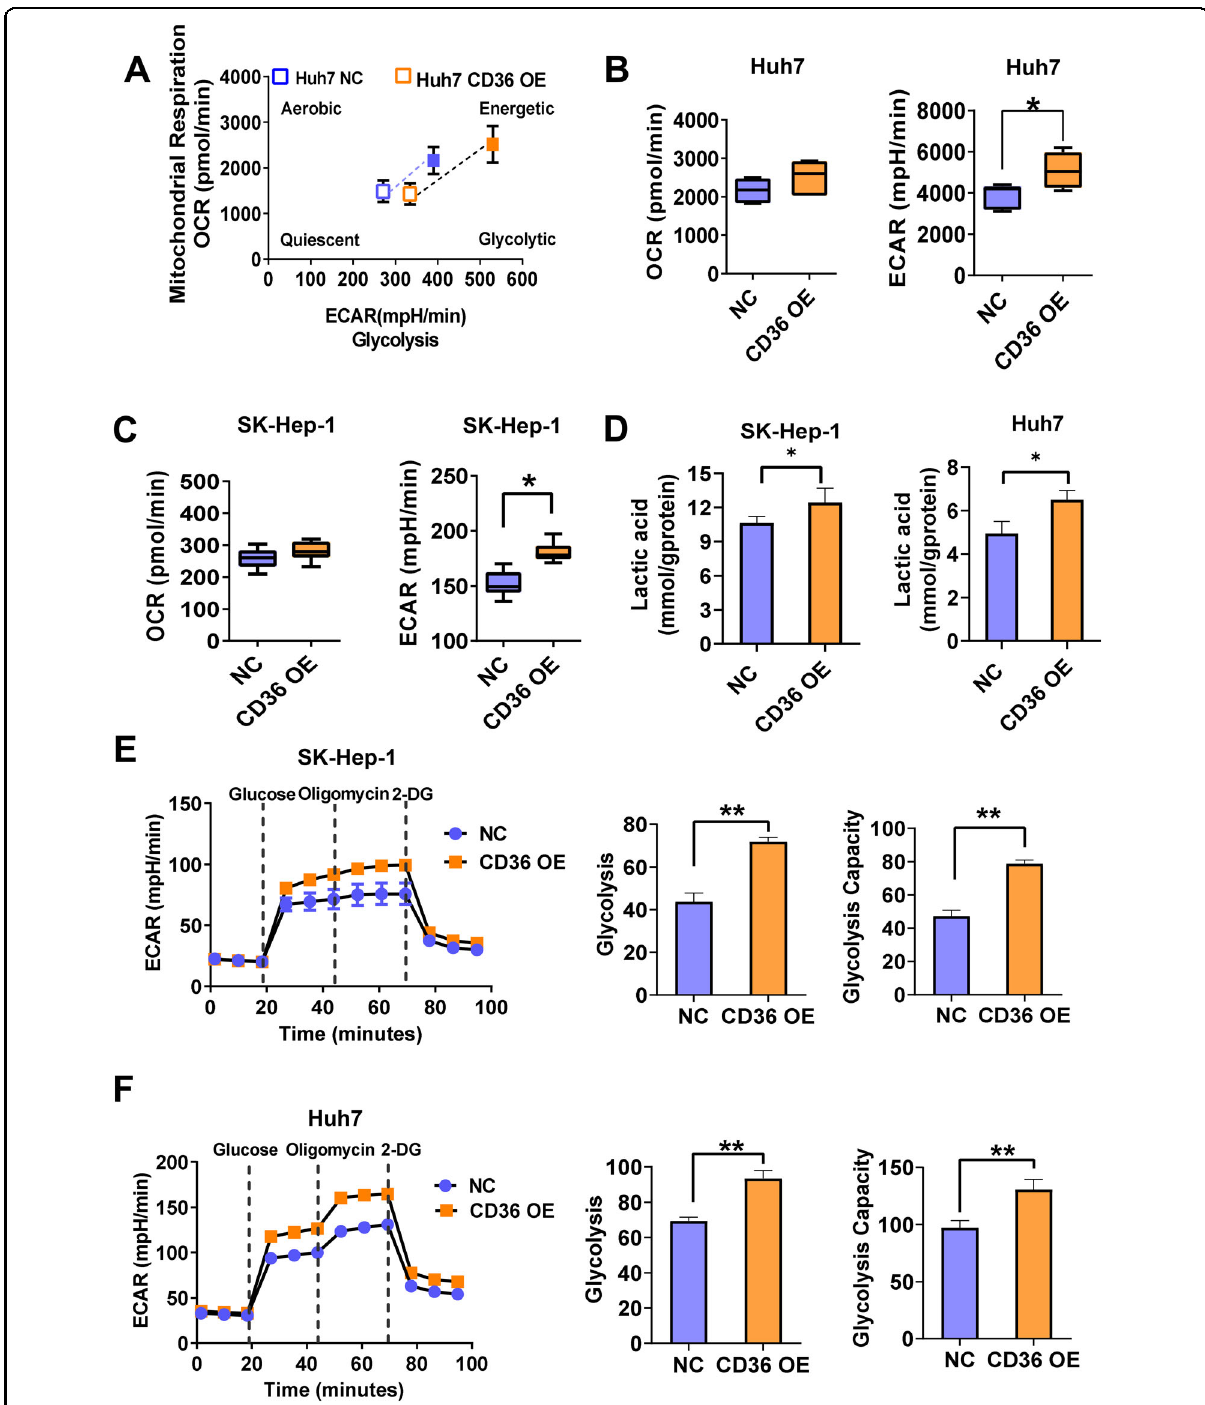
Fig. 5 CD36 promotes glycolysis in HCC cells. The energy metabolism phenotype and glycolytic capacity of CD36 OE or control cells were measured by the Seahorse XFe 24 Analyzer. A Energy metabolism phenotype of CD36 OE or control Huh7 cells. B , C The stressed OCR and ECAR of Huh7 and SK-Hep-1 cells ( n = 3). D The lactic acid production of SK-Hep-1 and Huh7 cells ( n = 6). E , F Glycolytic capacity of Huh7 and SK-Hep-1 cells was measured by glycolytic stress test ( n = 3), the key parameters of glycolytic fl ux including glycolysis and glycolytic capacity were shown on the right. All data are presented as mean ± SD. * P < 0.05 and ** p < 0.01 compared with the NC group. P -value was calculated using Student ’ s t